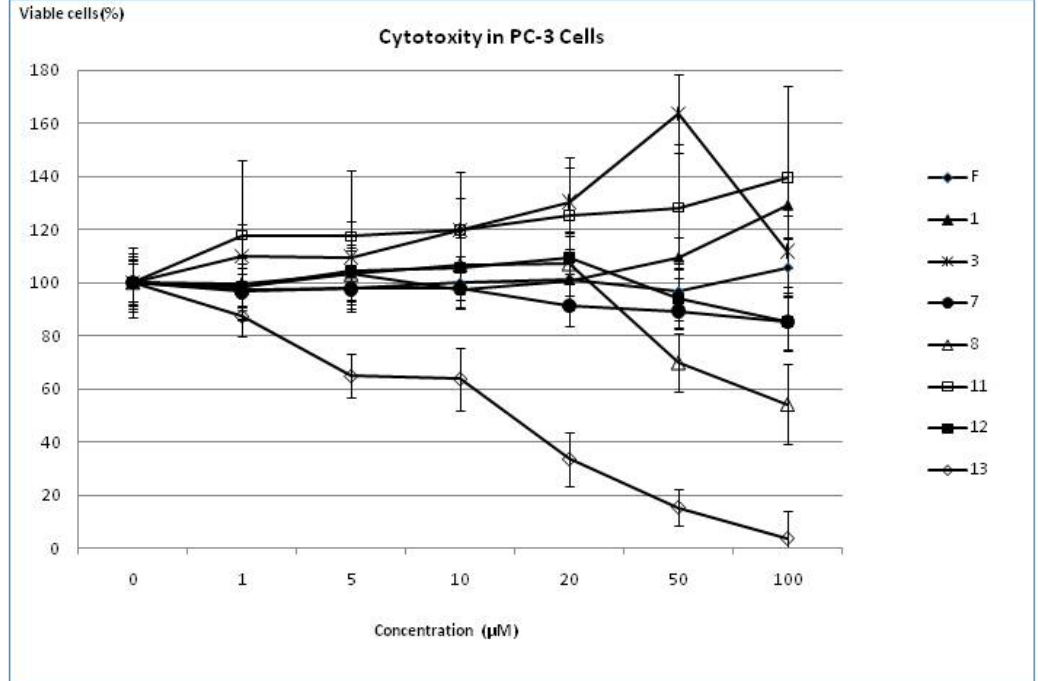
Figure 2. Cytotoxicity of F (finasteride) and 1 , 3 , 7 , 8 , 11 - 13 on PC-3